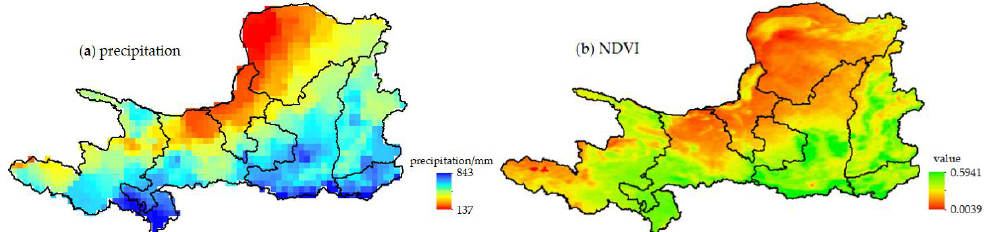
Figure 13. Spatial distribution of annual mean precipitation and NDVI in the Yellow River basin from 2000 – 2015: ( a ) Precipitation, ( b ) NDVI.